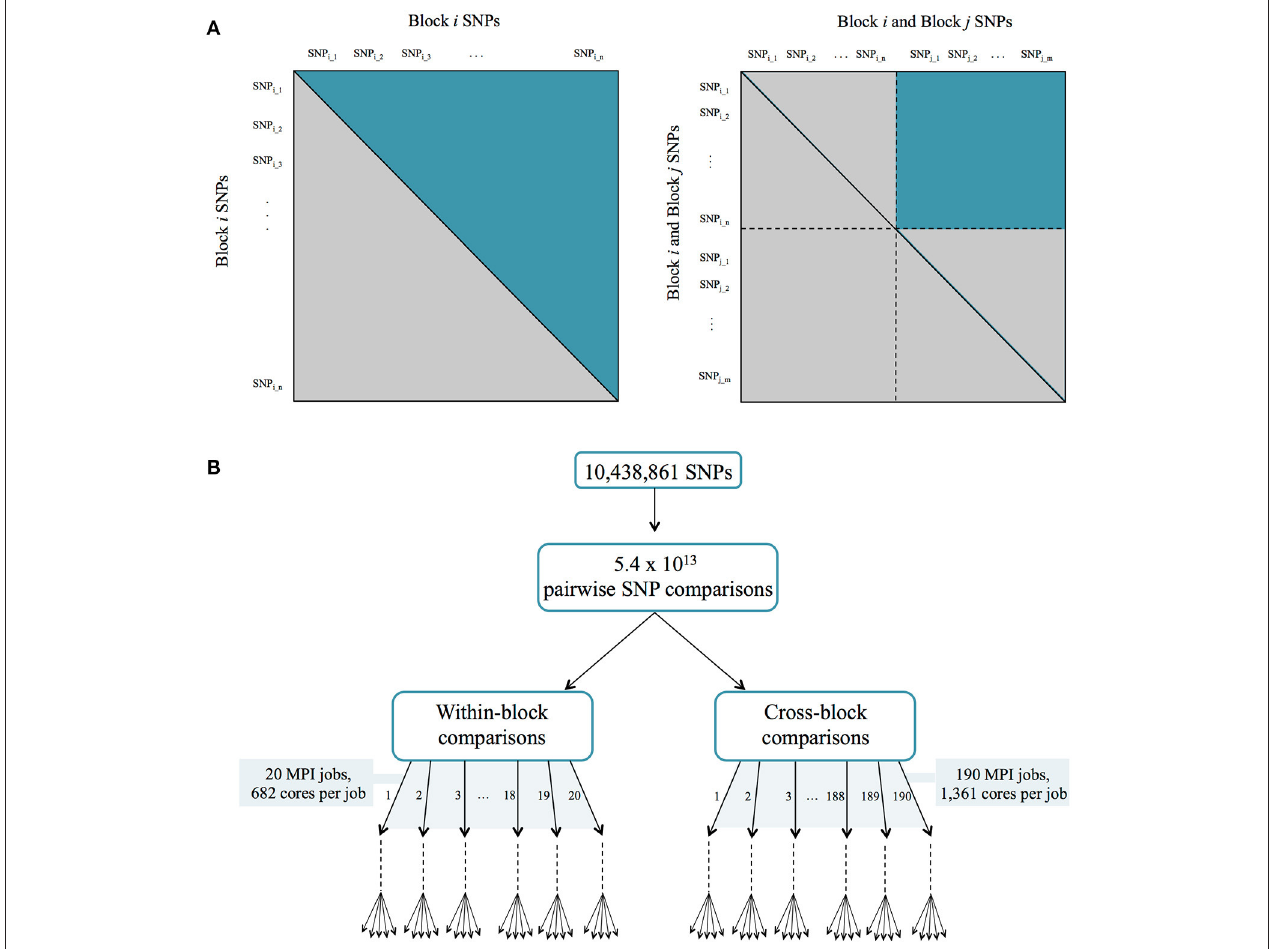
FIGURE 2 | (A) Parallelization strategy for ccc calculation between all pairs of SNPs. (B) MPI jobs for within and cross-block comparisons.